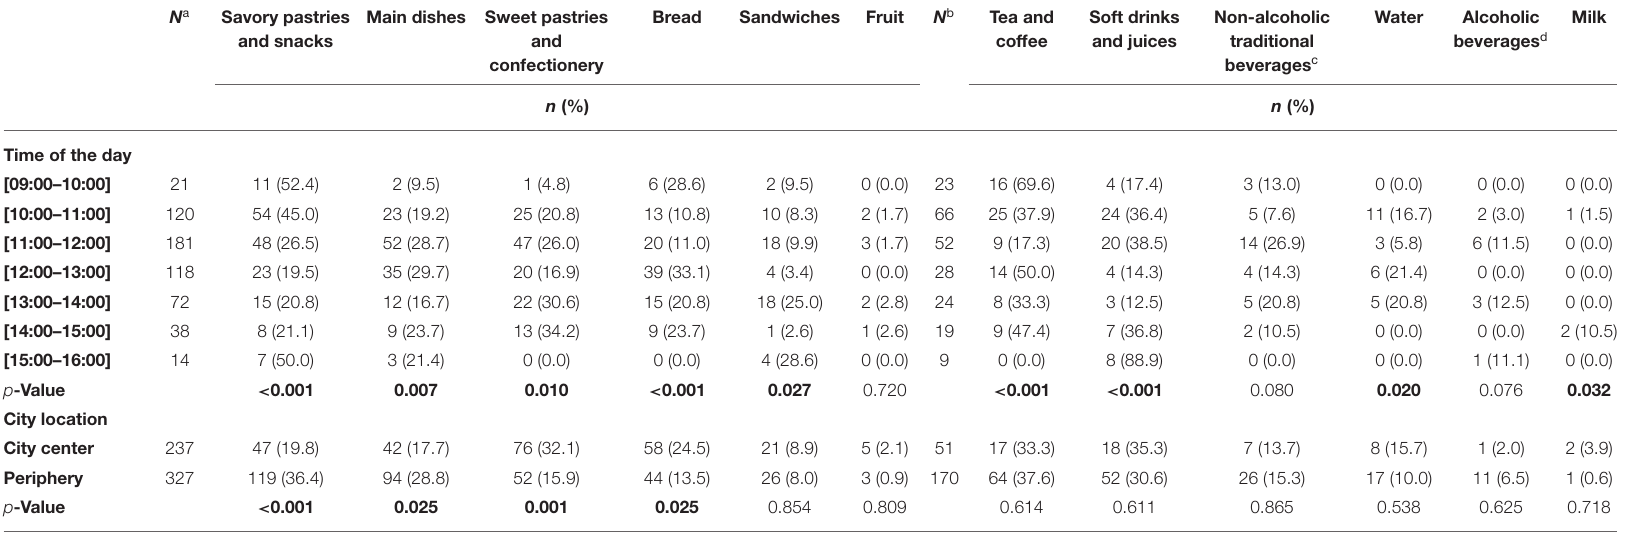
Soft drinks Non-alcoholic coffee and juices